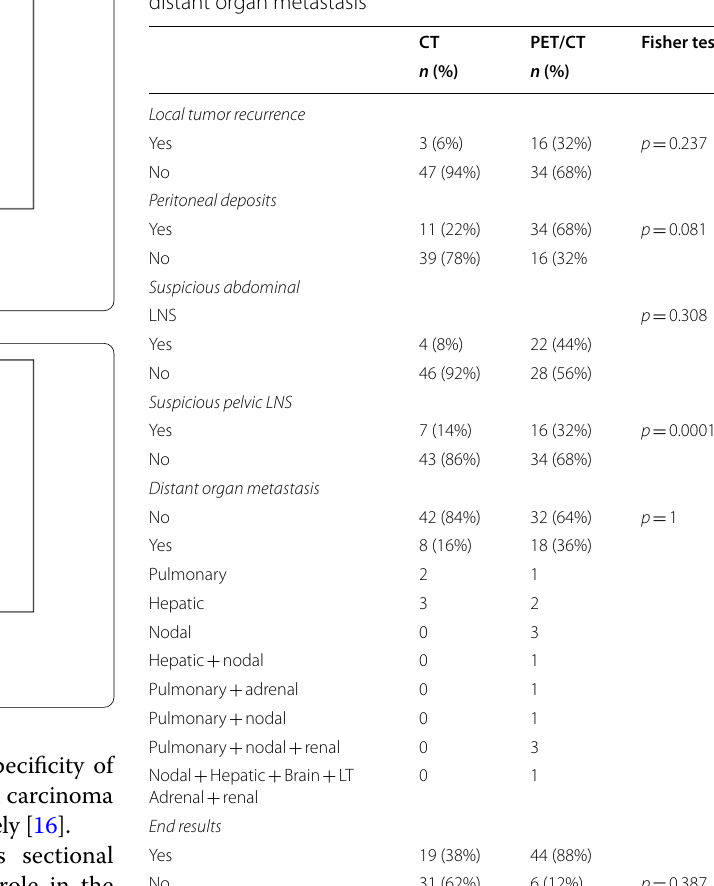
Table 4 Comparison between CT and PET/CT in detection of local tumor recurrence, peritoneal deposits, regional LNS and distant organ metastasis